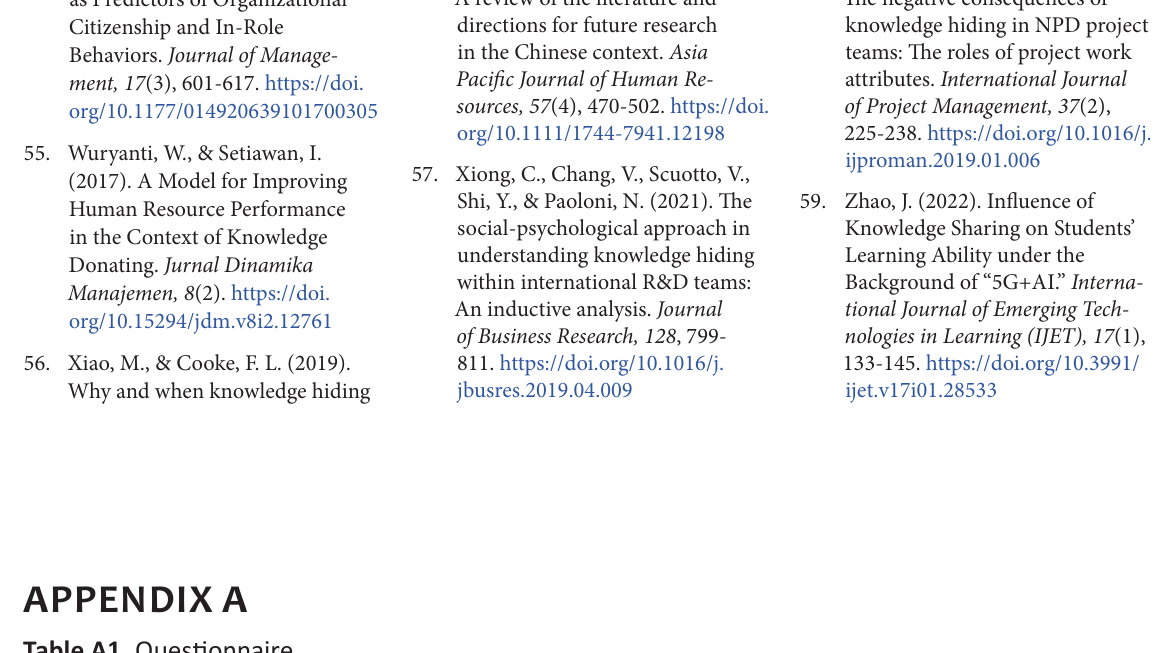
Interpersonal relationship